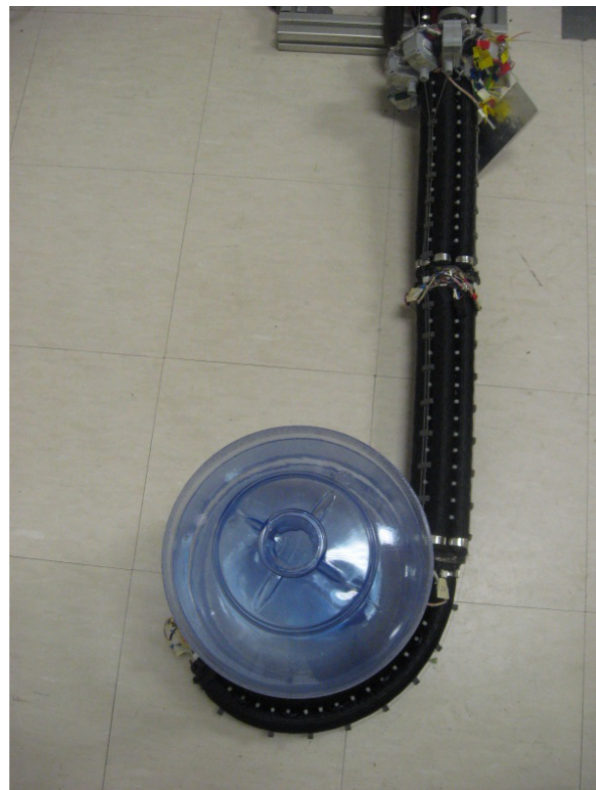
Figure 8. Continuum and point contacts